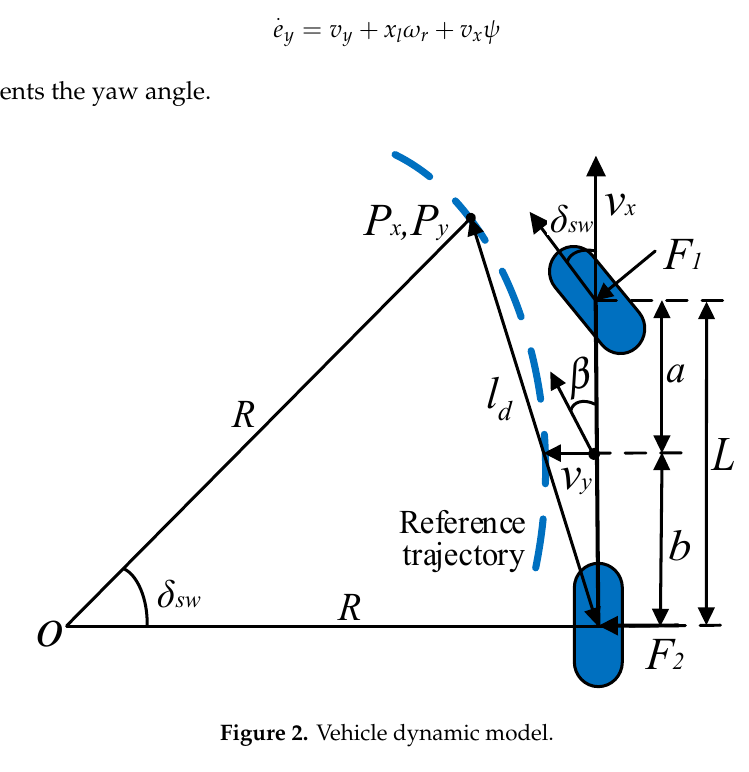
Figure 2. Vehicle dynamic model. Table 2. Parameters of the vehicle dynamic